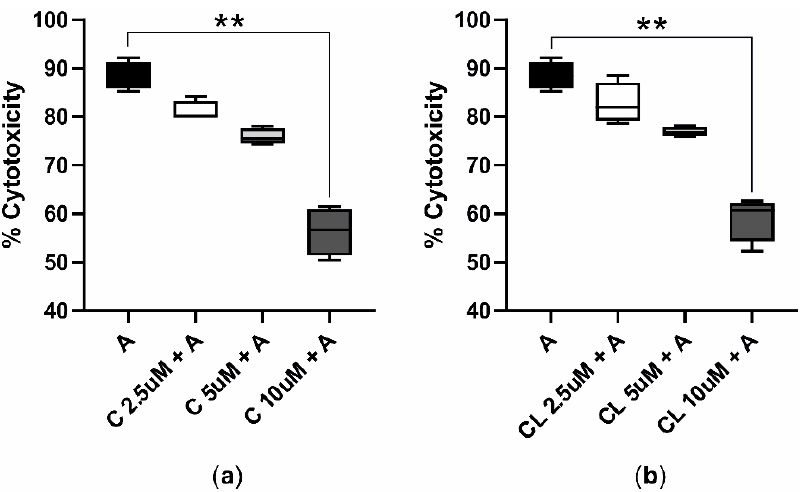
Figure 3. AFB1 cytotoxicity in presence of C or CL (16 + 48 h). The box and whiskers plots report the viability of BFH12 cells pretreated with C ( a ) and CL ( b ) increasing concentrations (2.5, 5, and 10 µ M) and exposed for 48 h to a combination of AFB1 3.6 µ M and C or CL (same concentrations reported above). ** p ≤ 0.01 (Kruskal–Wallis and Dunn’s multicomparisons tests; the mean of each condition was compared with the mean of the AFB1 condition). C = curcumin; CL = Curcuma longa ; A = AFB1.